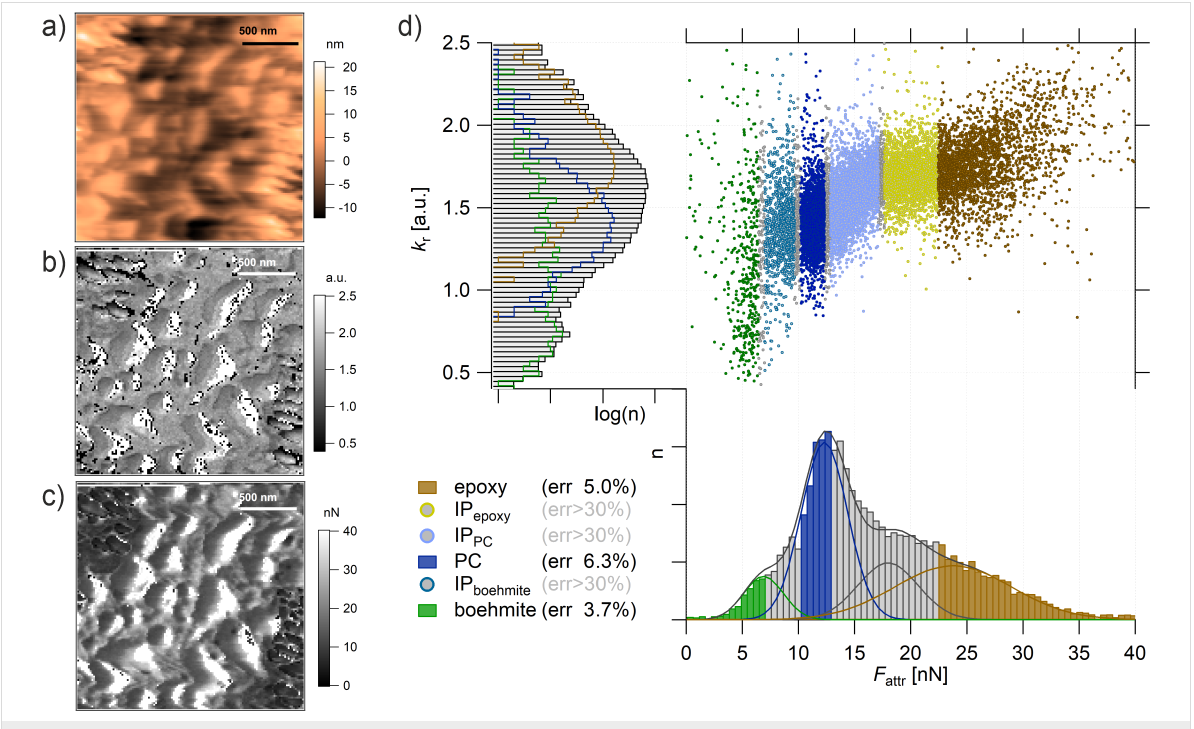
Figure 7: ImAFM ADFS (a) height, (b) k r , and (c) F attr map (128 × 128 points). (d) Property domain of the k r histogram, F attr histogram, and k r / F attr diagram. The k r histogram is deconvoluted with four Gaussian fits assigning epoxy (brown), PC (blue), and boehmite (green) to the measuring points (error < 7%). The measuring points with a larger error of assignment (>30%) are IP epoxy (yellow), IP PC (light blue, between epoxy and PC), and IP boehmite (turquoise, between PC and boehmite). See also the k r / F attr diagram (top right). The measurements were performed with tip E.